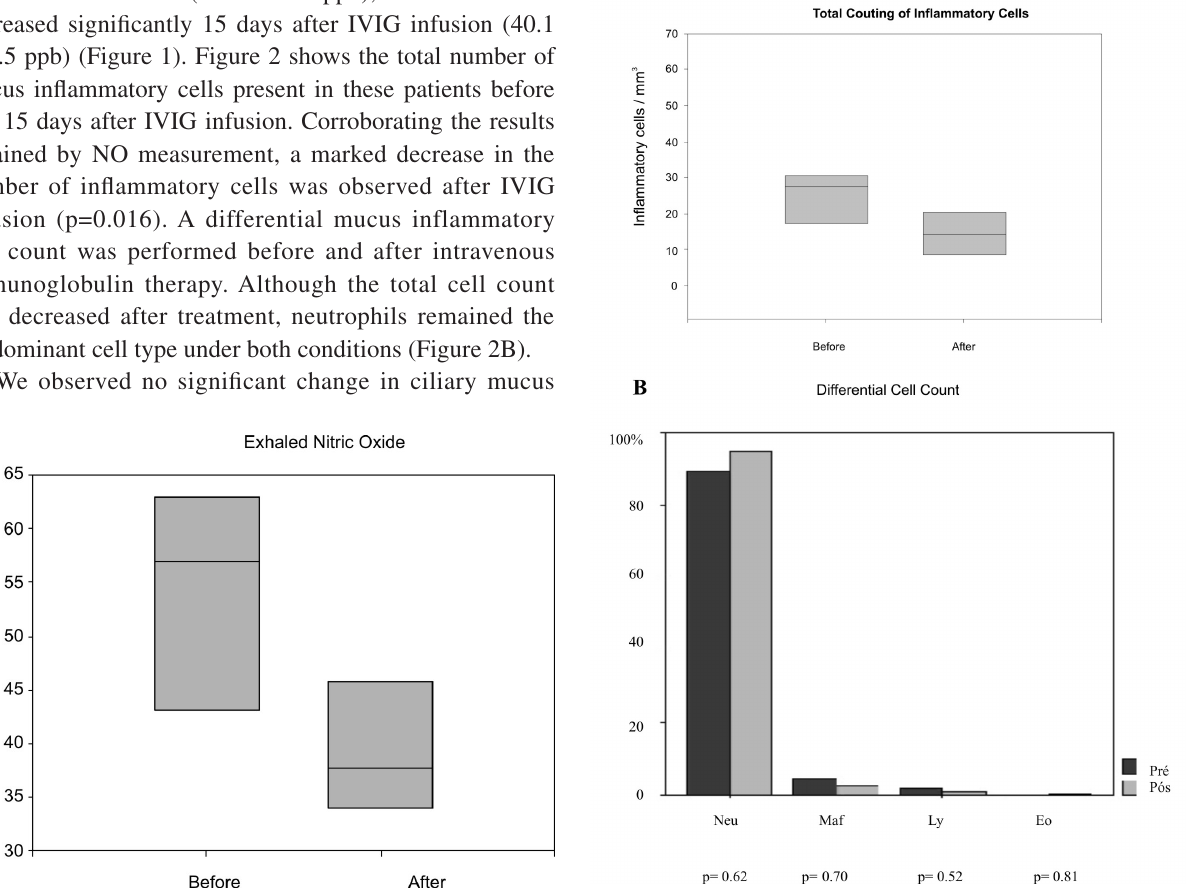
Figure 2 - Total inflammatory cell counts (A) and the differential cell counts (B) (Neu=neutrophils, Maf=macrophages, Ly=Lymphocytes and Eo=eosinophils) in sputum before and after intravenous